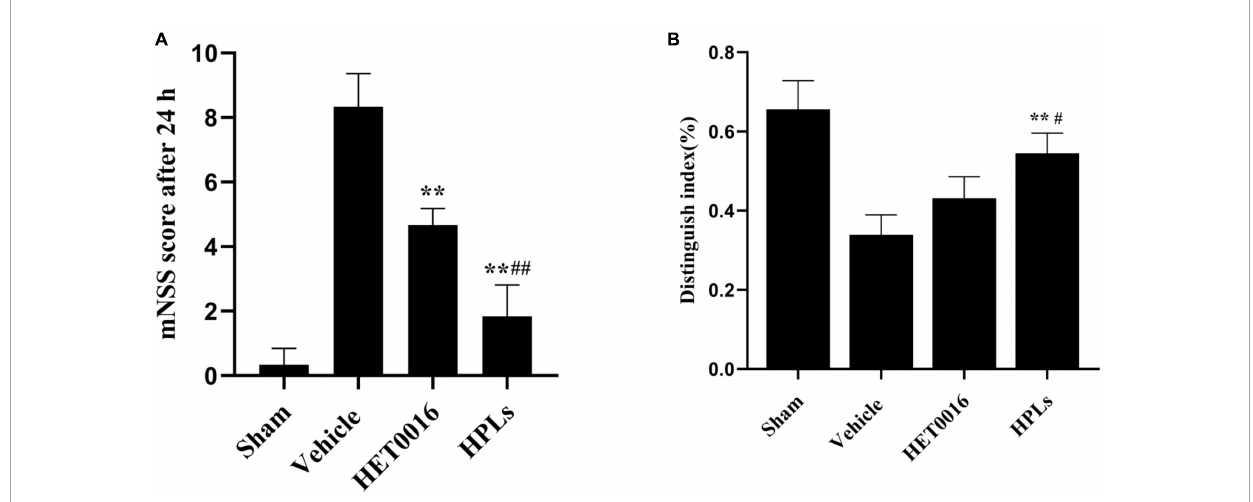
FIGURE7 HPLs ameliorated TBI-induced learning/memorial function. (A) Neurological function was analyzed using mNSS at 24 h after TBI. (B) Analysis using the New Object Recognition Test at 30 day after TBI. Data are presented as mean ± SD. * p < 0.05, ** p < 0.01 versus Vehicle, # p < 0.05, ## p < 0.01 versus HET0016, n = 6 in each